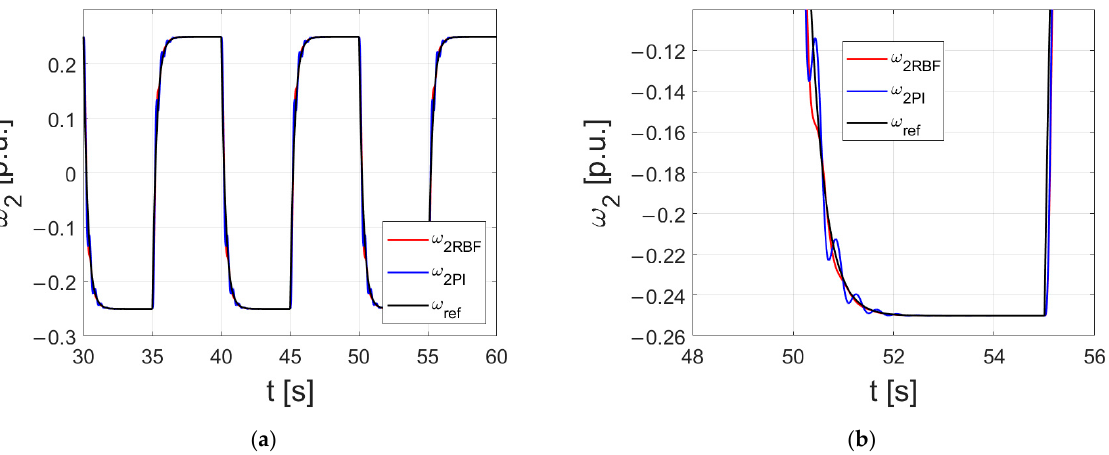
Figure 6. Simulation results—the impact of the system’s parameter change: ( a ) general overview of the simulation run; ( b ) a zoom-in showing the work of the controller under different operating conditions.